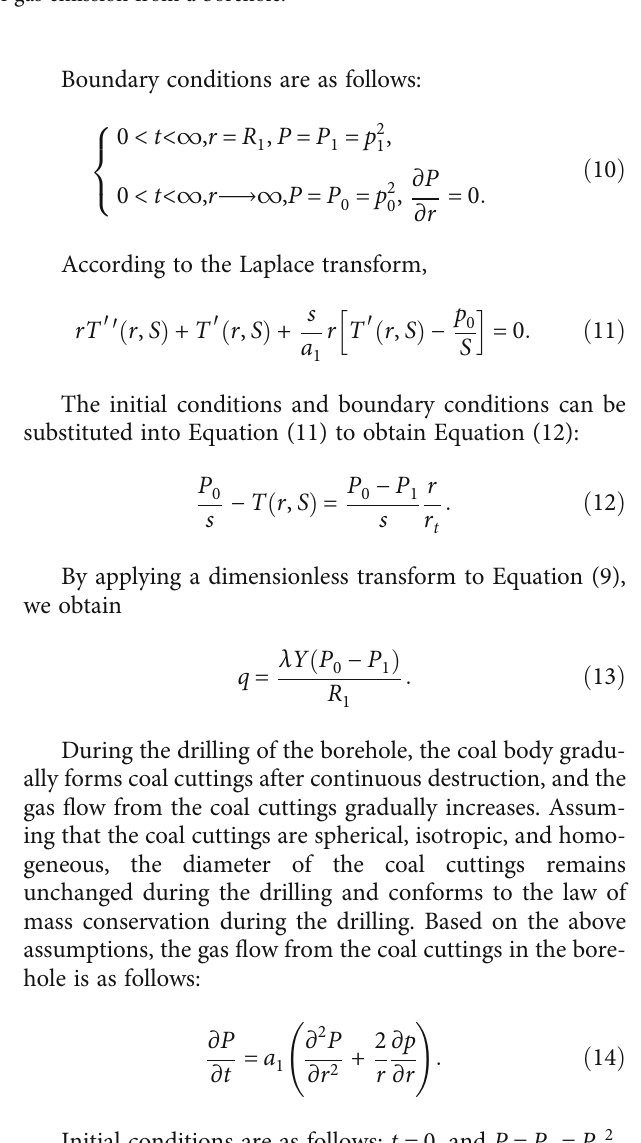
Figure 3: Schematic diagram of gas emission from a